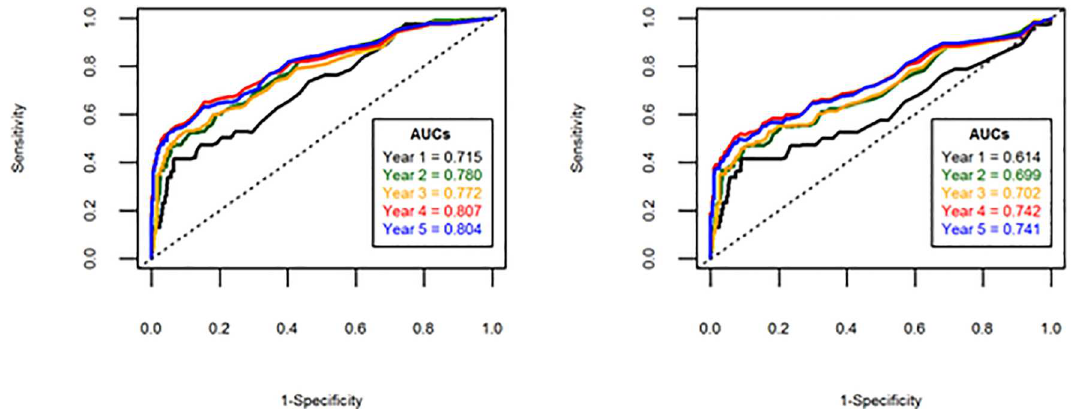
Fig 3. Time-dependent ROC curves depicting the accuracyof the final CEA value (left) and any rise above threshold